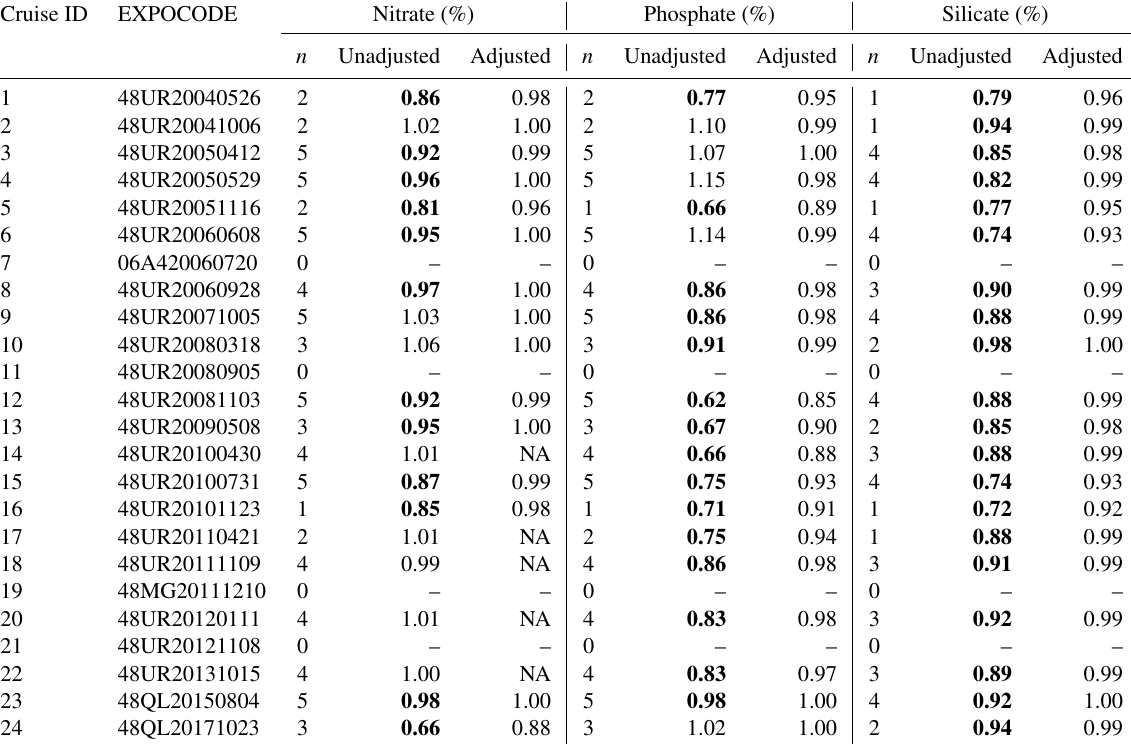
Table 6. Secondary QC toolbox results: improvements of the weighted mean of absolute offset per cruise of unadjusted and adjusted data; n is the number of crossovers per cruise. The numbers in bold (less than 1) indicate that the cruise data are lower than the reference cruises. NA: not adjusted.